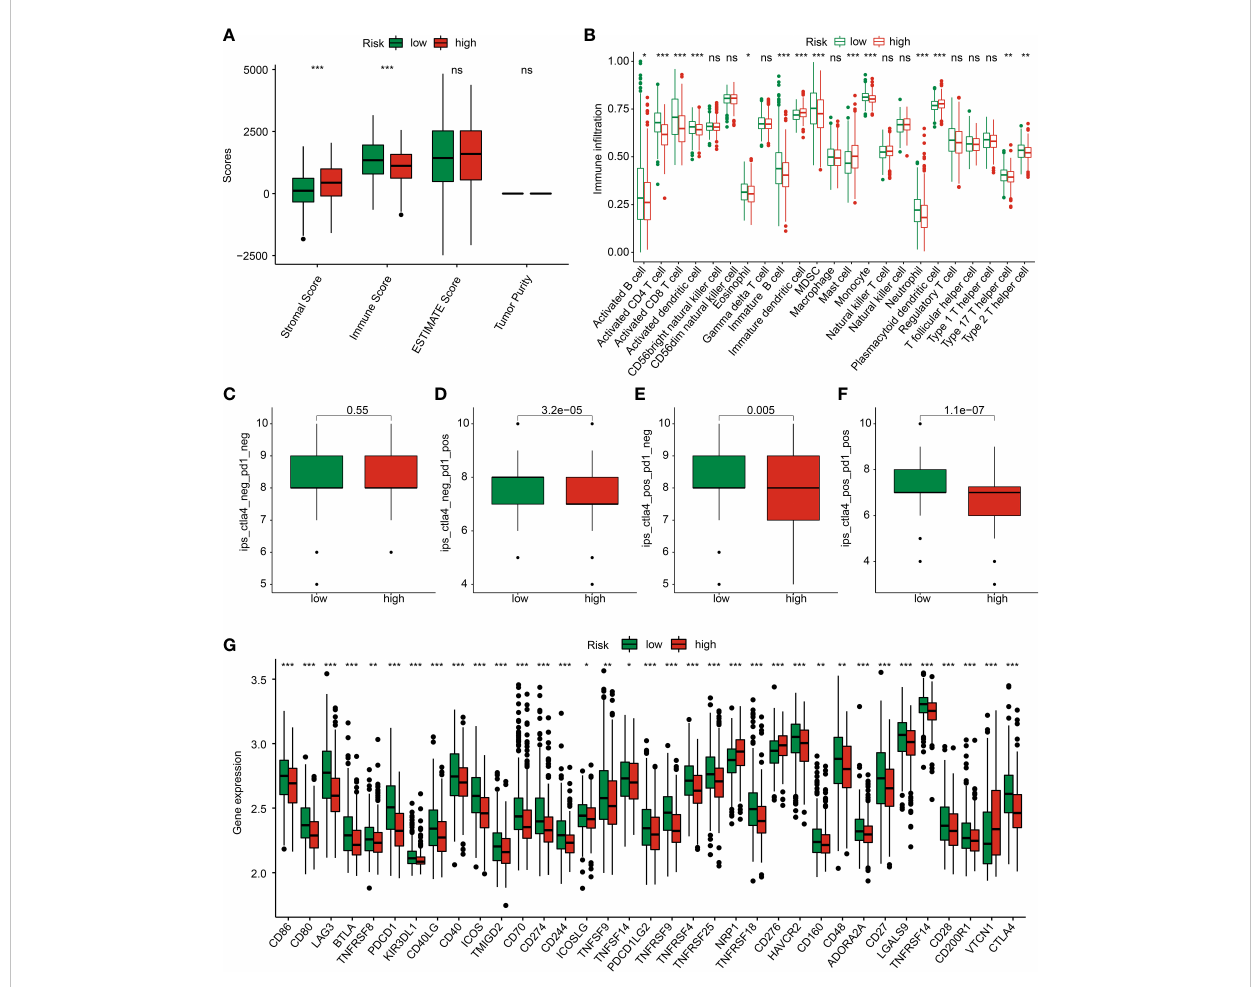
FIGURE 9 TME landscape and immunotherapy response of GC in the risk subgroups. (A) ESTIMATE score. (B) The proportion of 23 immune cells estimated by ssGSEA. (C – F) IPS score. (G) Immune checkpoints expression. *p < 0.05, **p < 0.01, ***p < 0.001. ns, no signi fi